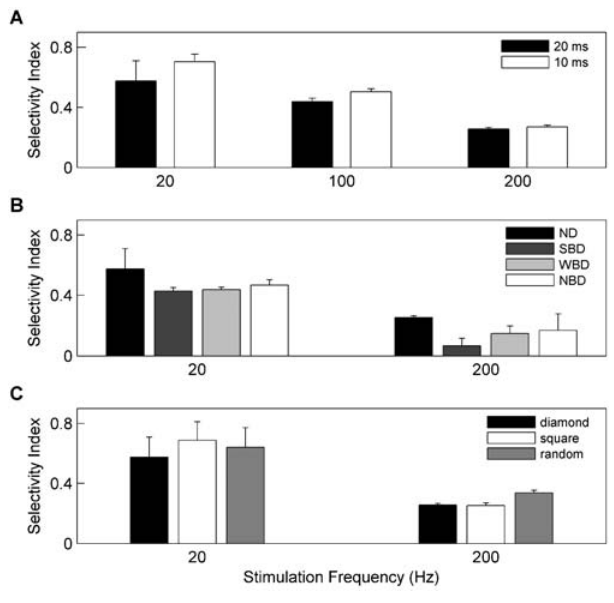
Figure 3. Robustness to changes in key model parameters. All panels represent the ‘‘Selectivity Index’’ (see Materials and Methods) computed on spiking responses. A: Dependence on time window for response estimation. Selectivity index as a function of stimulus frequency assessed using two different integration time windows after each deflection (10 and 20 ms). B: Dependence on short-term synaptic plasticity. The selectivity index was evaluated for conditions differing in how synaptic depression properties were matched across excitatory and inhibitory conductances (ND: no depression, same model as in other figures; SBD, WBD and NBD defined in Results). C: Dependence on choice of grid geometry on which whisker deflections were defined (square: deflections on square grid; diamond: on diamond grid; random: random walk deflections; see Materials and Methods for full explanation and Fig. 2, bottom, for schematic of diamond grid). In all cases, response selectivity was weakened at high frequencies. Error bars: standard error of mean across